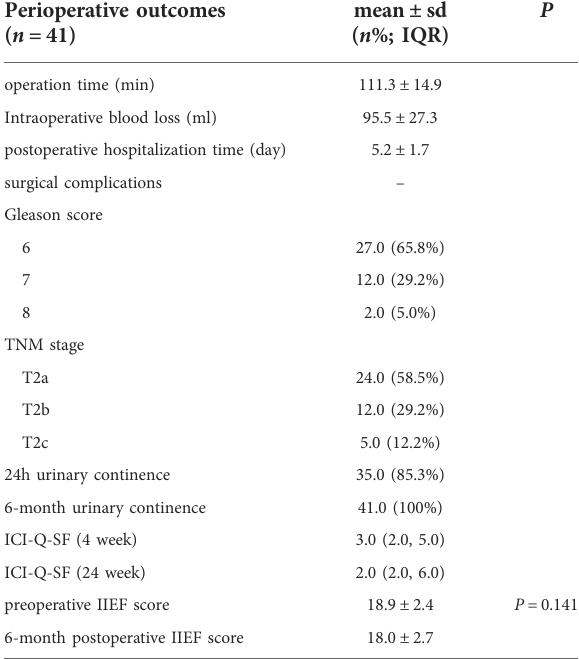
TABLE 1 Perioperative outcomes. Perioperative outcomes ( n =